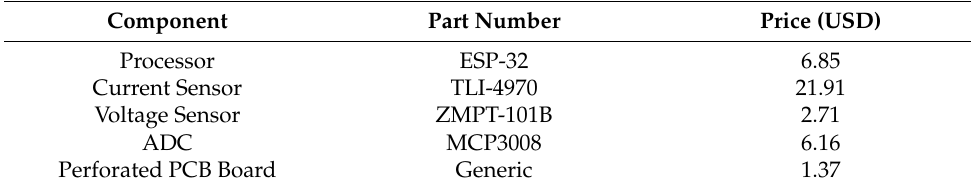
Table 4. Cost of